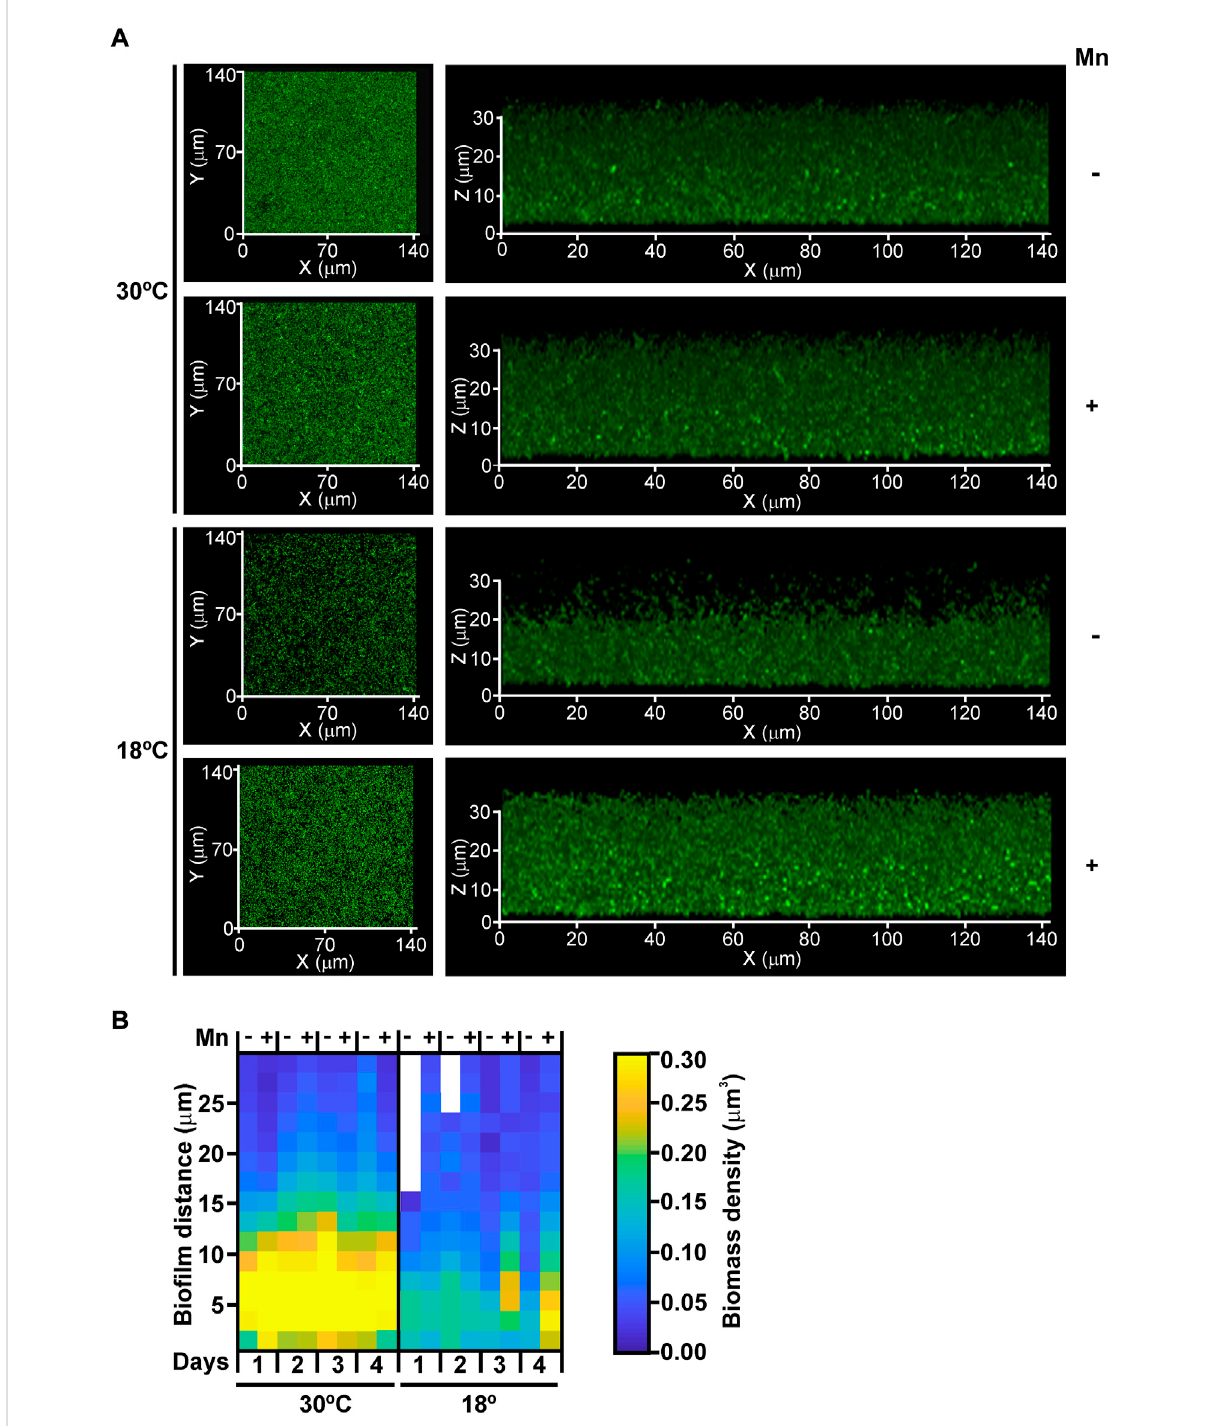
FIGURE 2 The effect of Mn(II) and temperature on bio fi lm development. (A) MOB-449-pMP2424 bio fi lms grown in Lept or Lept + Mn media at 18 ° C and 30 ° C were analyzed by confocal microscopy. Photographs of the xy and xz projections of three-dimensional MOB-449 bio fi lms acquired from 3- days-oldbio fi lmsareshown.Thethree-dimensionalprojectionsof39stacksweregeneratedinZeissBlack(Zeiss).Bio fi lmanalysisarerepresentative of three biological replicates. (B) Quanti fi cation of the bio fi lm biomass (colors intensity) during 4 days of growth in Lept or Lept + Mn media at 18 ° C and 30 ° C. The spatial distribution of the structural parameter -local density- for each condition is shown in the heatmap, the lack of color indicate the absence of bio fi lm at this depth. The 3D internal bio fi lm architectures are representative of three biological